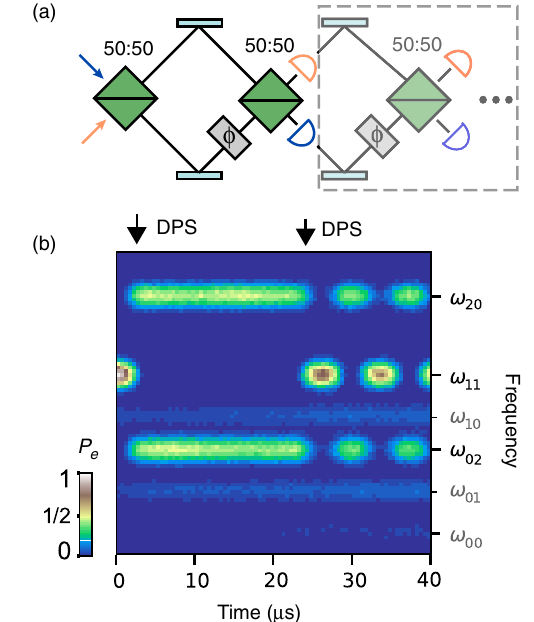
FIG. 5. Cascaded Mach-Zehnder interferometers composed of BS, DPS, and photon counters. (a) Conceptual implementation of programmable cascaded Mach-Zehnder (MZ) interferometers between two detuned modes. We can measure the state of the system after each operation and implement DPS on